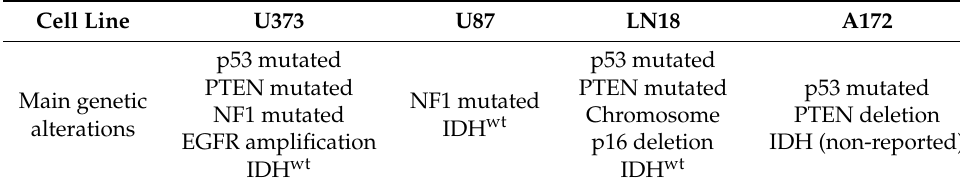
Table 1. Main genetic alterations of GBM cell